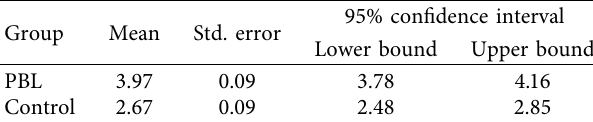
Table 4: Descriptive statistics in posttest.